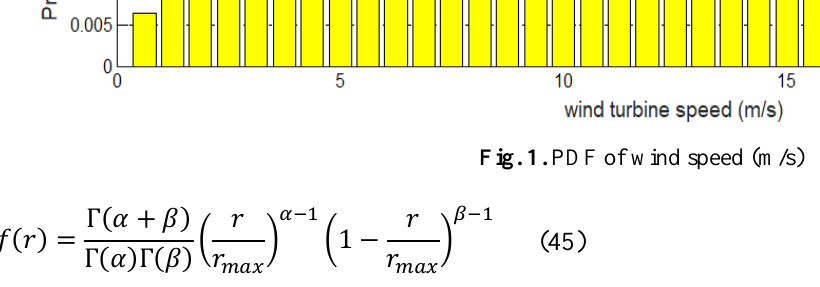
Fig. 1. PDF of wind speed